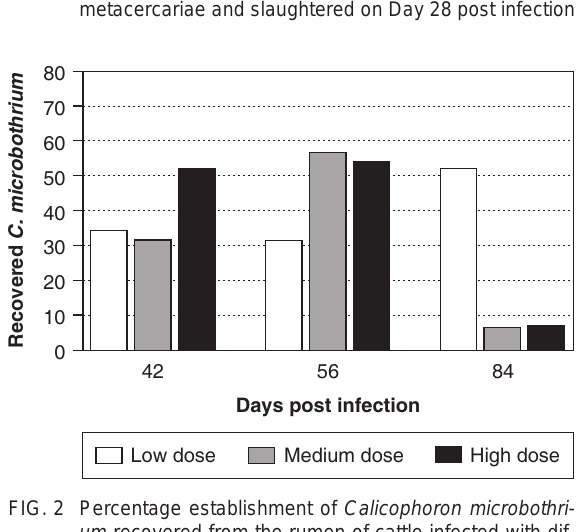
FIG. 1 Distribution patterns of recovered Calicophoron micro- bothrium (%) in cattle infected with different doses of metacercariae and slaughtered on Day 28 post infection